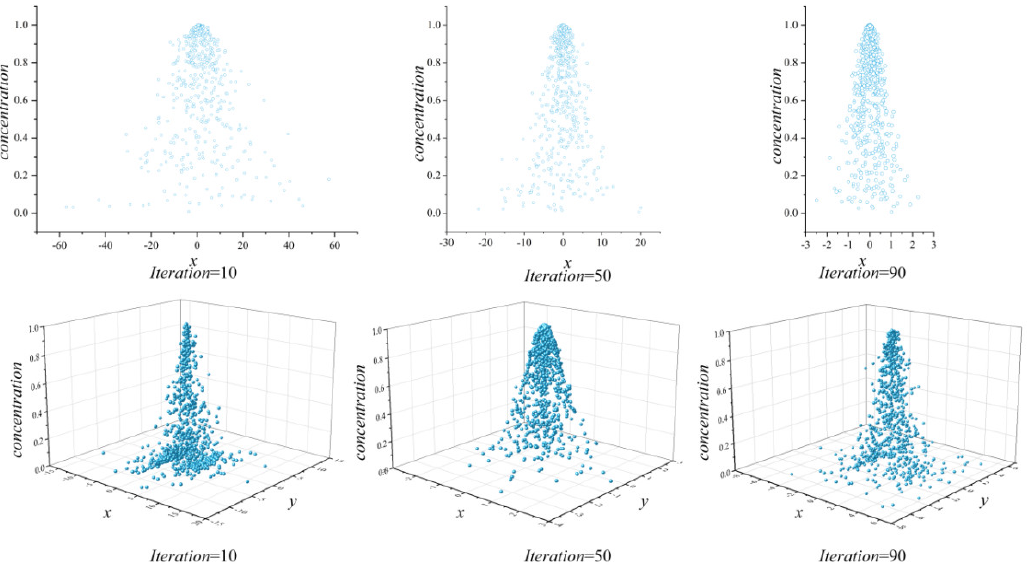
Figure 6. Dispersion of pheromones in 1−D and 2−D dimensionality space when the number of iterations is 10, 50, and 90.